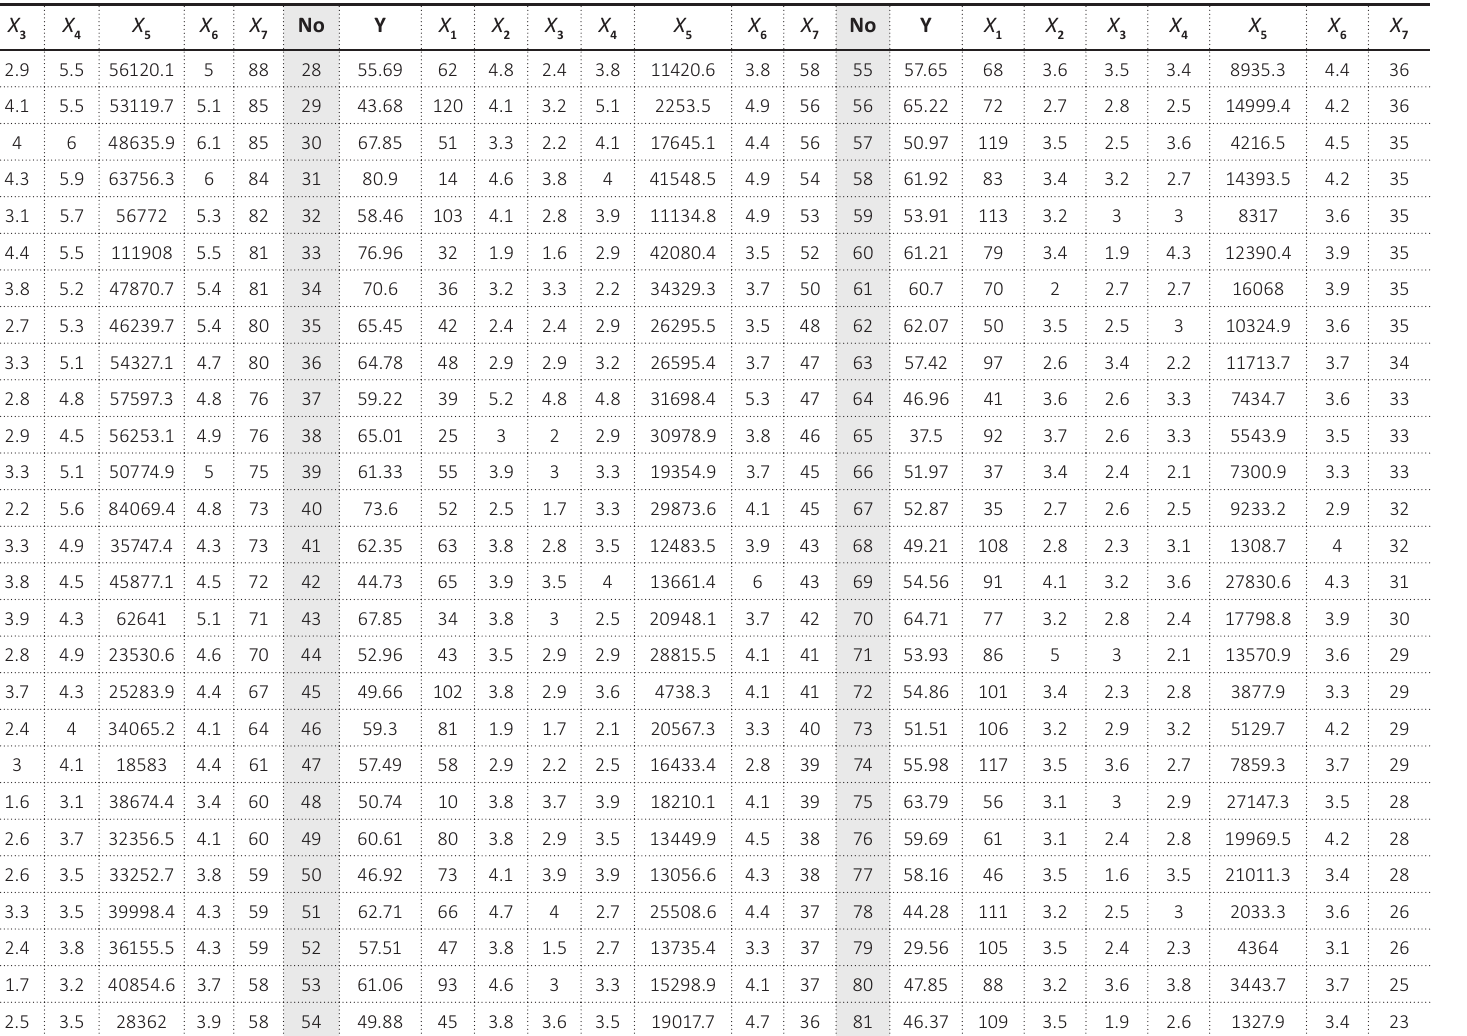
Table A1. The initial dataset for constructing the regression